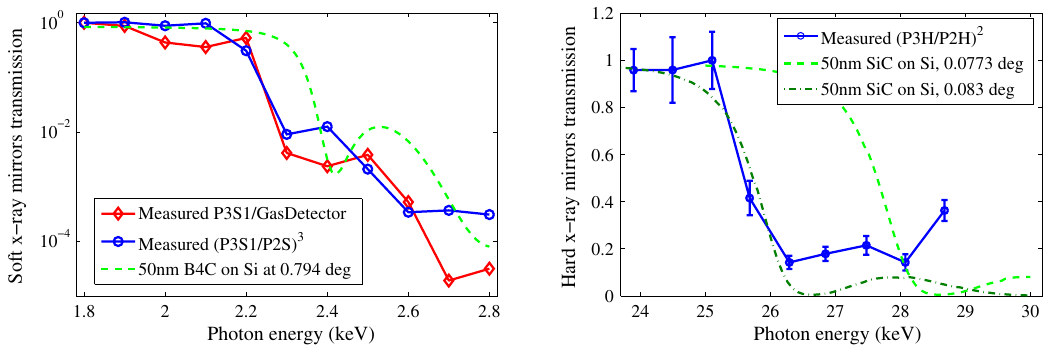
FIG. 3. Transmission plots show the photon energy cutoffs of the soft x-ray (left plot) and hard x-ray (right plot) experimental beam lines. On the left, blue circles show the cube of the ratio of intensities on P3S1 and P2S, while the red diamonds give the ratio from P3S1 to the full pulse energy. Both results match the expected transmission (dashed green curve) [10,12]. On the right, blue circles give the square of the ratio of intensities measured on P3H and P2H. The dashed curve gives the expected transmission at the nominal 0.0773 (cid:1) angle; however, we find a better match for 0.083 (cid:1) angle (dot-dashed curve). Hard x-ray measurements rely on the third harmonic, resulting in lower resolution than for the soft x-ray measurements. In both cases, the experimental curves are normalized to one at the maximal